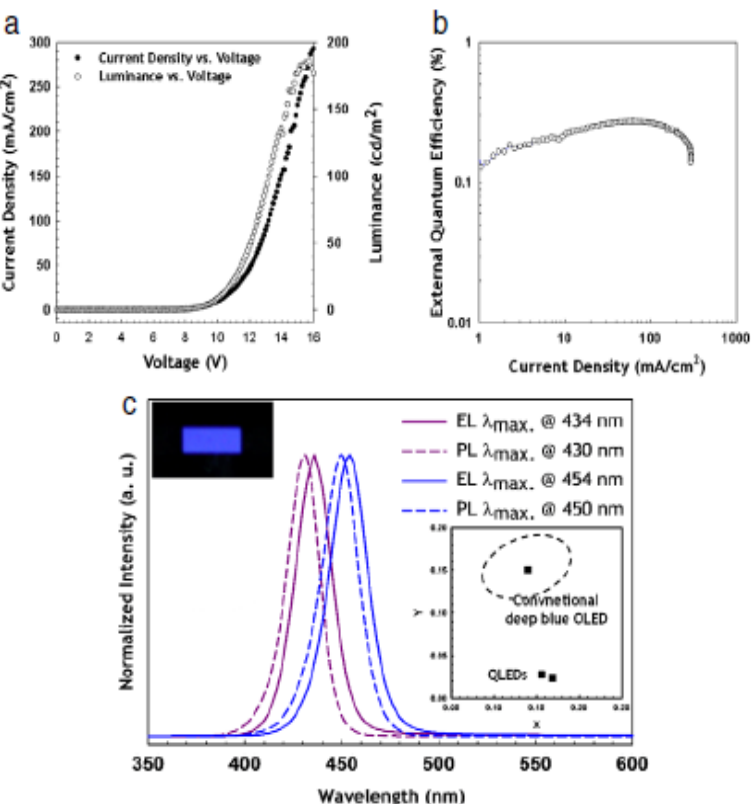
Figure 18. Characteristics of blue emitting QLED using CdZnS/ZnS Qdots: (a) L-I-V characteristics of QLED (b) EQE vs. current density and (c) EL and PL spectra from devices. Insets in (c) show a blue emitting electroluminescence device pixel and CIE color coordinate of the QLED [244] (Reproduced with permission from IOP Publishing